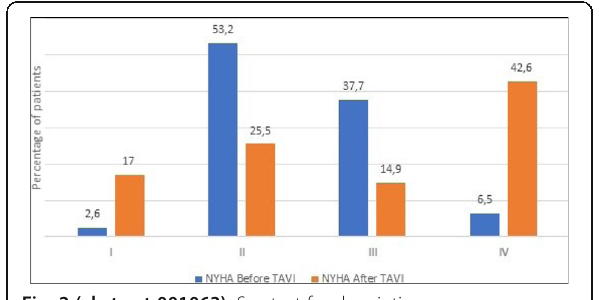
Fig. 2 (abstract 001063). See text for